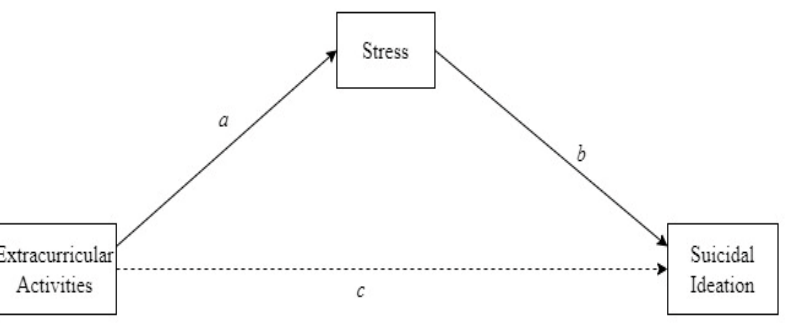
Figure 1. Covariates in mediation model of extracurricular activities, stress, and suicidal ideation. Table 3. The mediation effect of stress on the relationship between extracurricular activities and suicidal